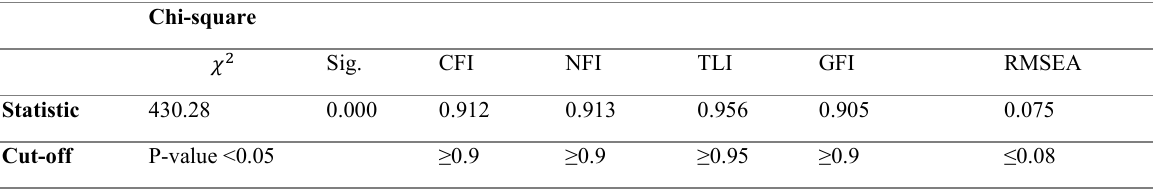
Table 5: Fit indices for the empathy SEM